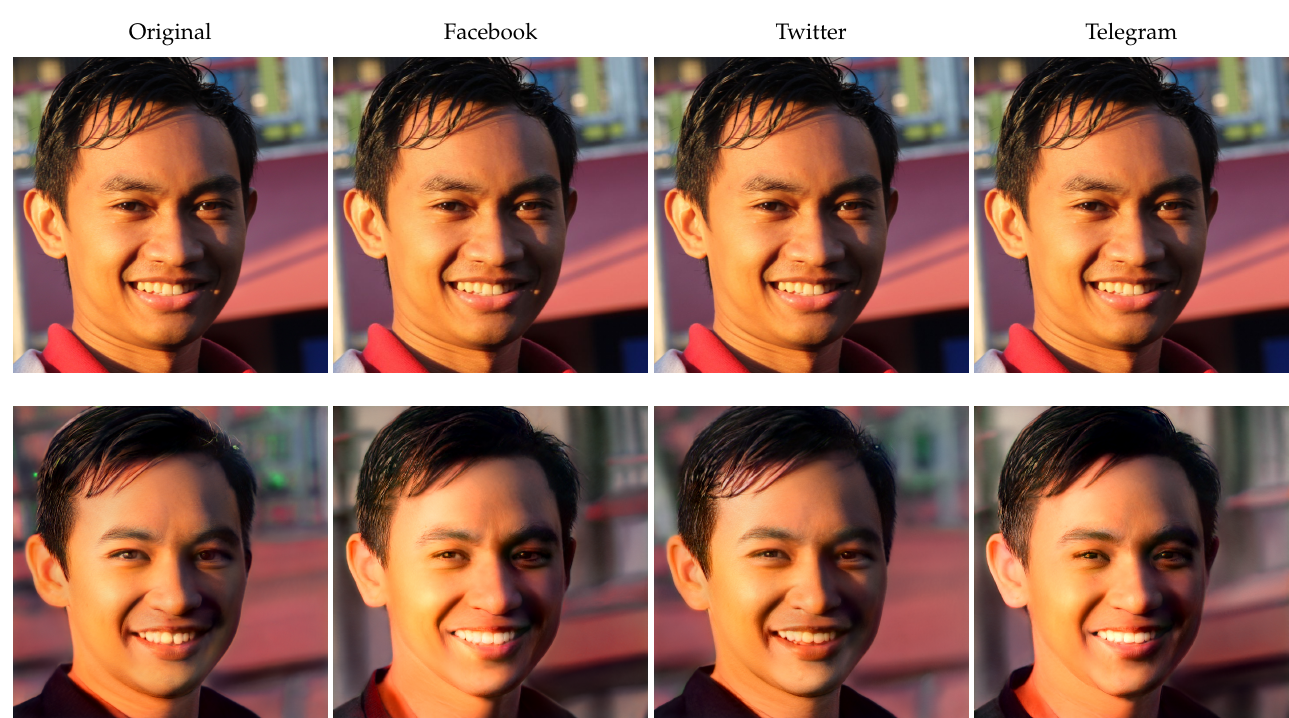
Figure 16. Shared images before (top row) and after (bottom row) the